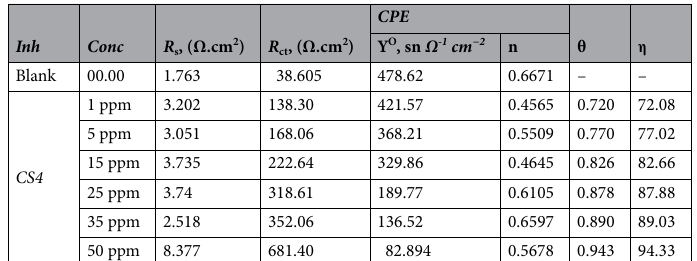
Table 2. EIS parameters and inhibition efficiency values for CS -metal in 1 M HCl with and without various concentrations of CS4 compound at room temperature.